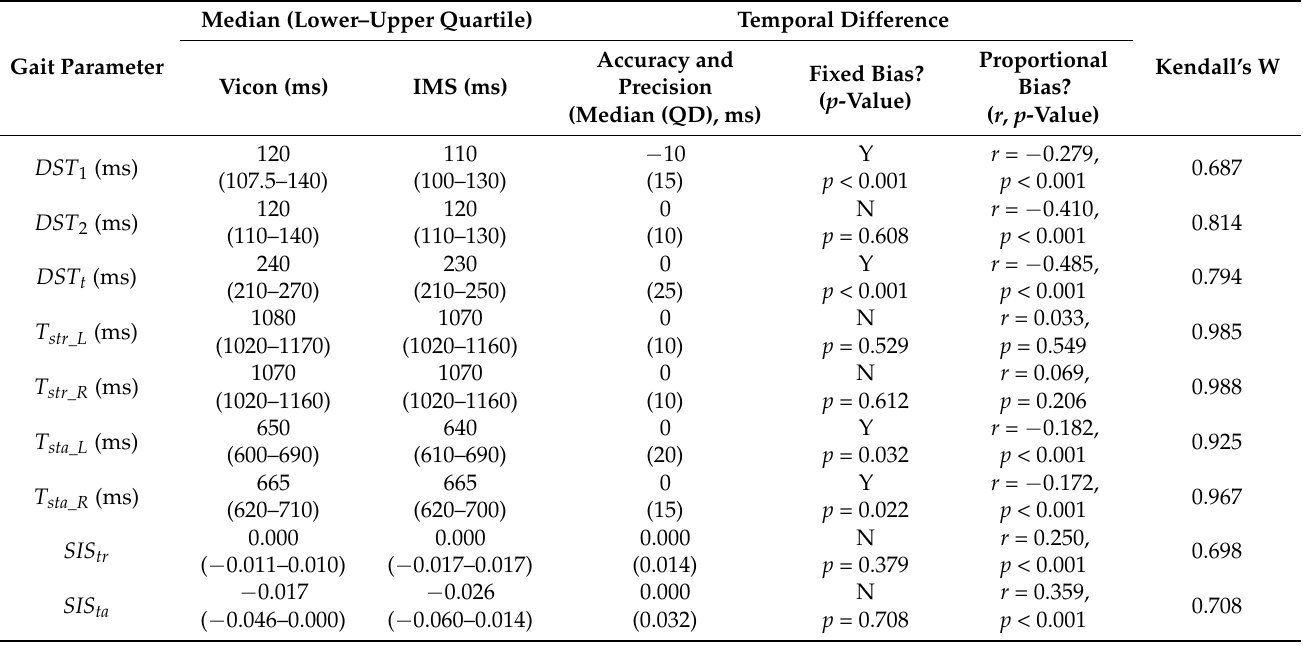
Table 2. Summary of the synchronicity evaluation results for candidate